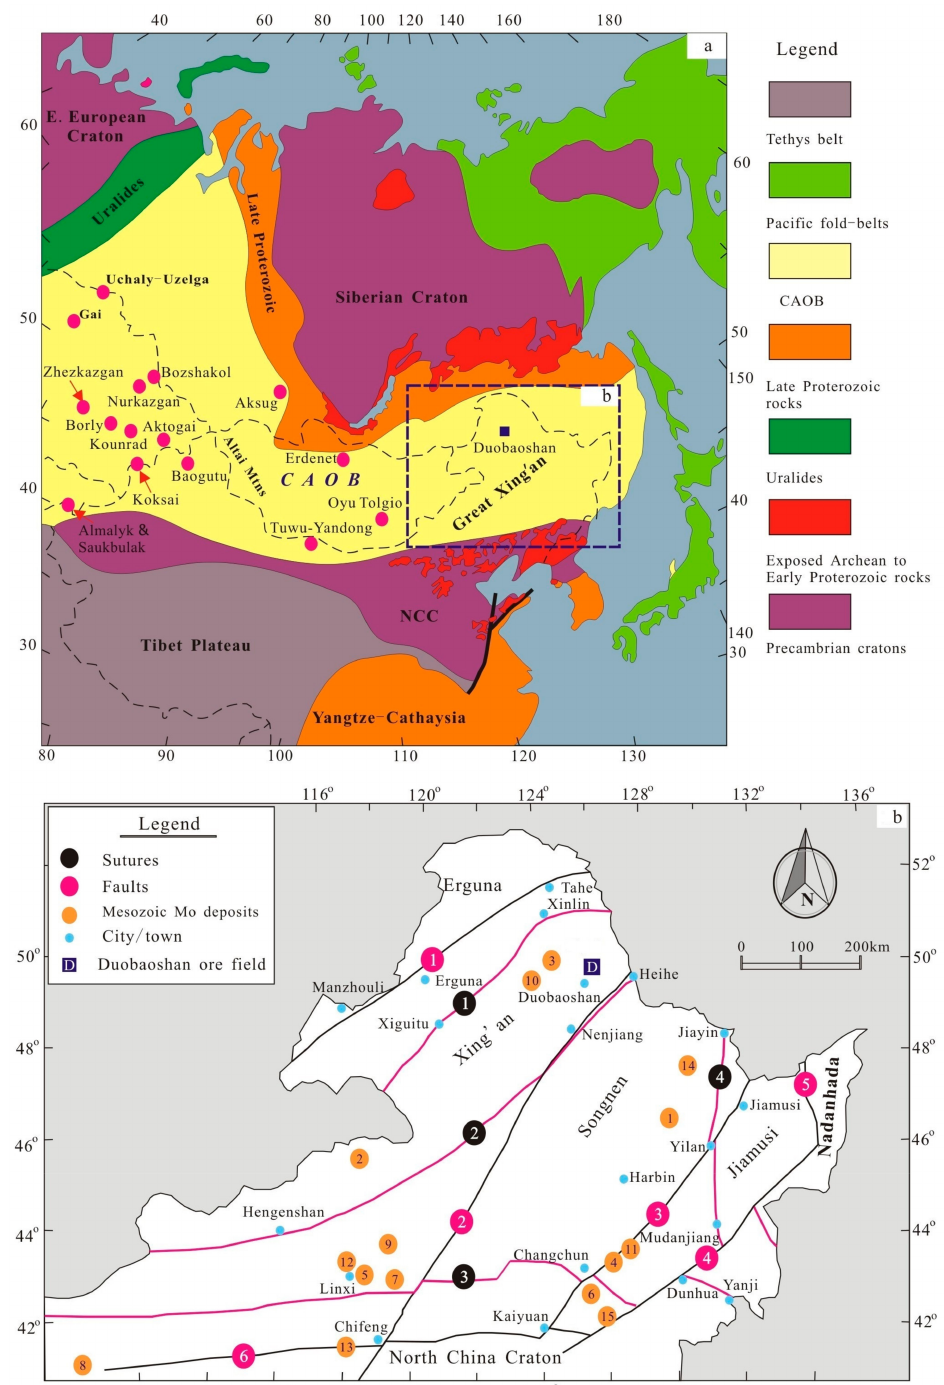
Figure 1. ( a ) Tectonic map of the CAOB and location of the DBS-TS porphyry Cu-Mo deposit (modified after [14]). ( b ) Tectonic framework of NE China (after [15]). Other porphyry Cu-Mo-(Au) deposits in CAOB are also shown in Figure 1a (data source: [16,17]). In ( b ), black circles with numbers in are sutures (1 = Xinlin–Xiguitu, 2 = Hegenshan– Heihe, 3 = Solonker–Xar Moron–Chandchun–Yanji, 4 = Mudanjiang–Yilan); pink circles with numbers are regional faults (1 = Derbugan, 2 = Nenjiang–Balihan, 3 = Jiamusi–Yilan, 4 = Dunhua–Mishan, 5 = Yujinshan, 6 = Chifeng–Kaiyuan); orange circles with numbers are Mesozoic porphyry Mo deposits in NE China (1 = Chalukou, 2 = Caosiyao 3 = Daheishan 4 = Luming, 5 = Diyanqin’amu, 6 = Jidetun, 7 = Xing’a, 8 = Fu’anpu, 9 = Dasuji, 10 = Hashitu, 11 = Chehugou, 12 = Hutulu, 13 = Yangchang, 14 = Haisugou, 15 = Shabutai; data source: